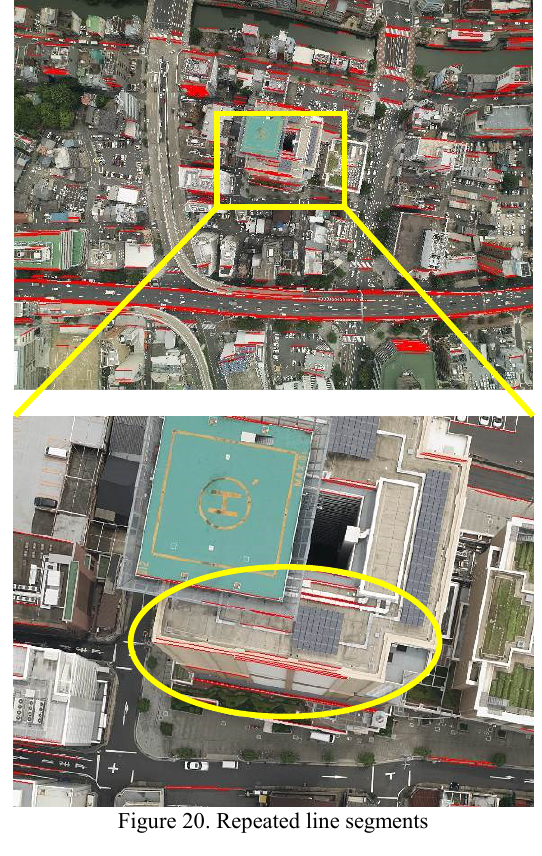
Figure 20. Repeated line segments